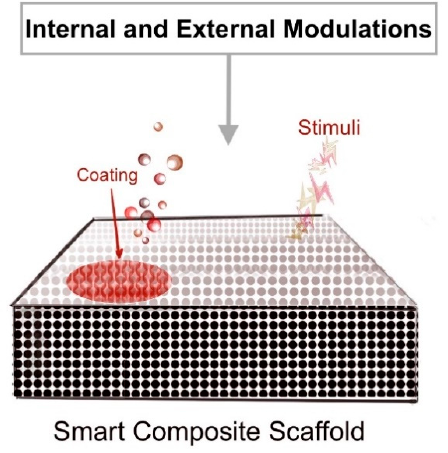
Figure 3. Smart sca ff olds for dentin pulp regeneration. Image adapted from Perez et al. [118] and Figure 3. Smart scaffolds for dentin pulp regeneration. Image adapted from Perez et al. [118] and Moussa et al. Moussa et al. [119].